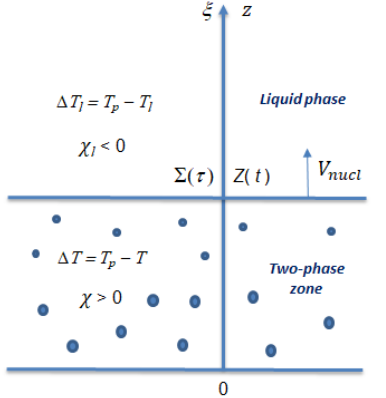
Figure 1. An illustration of the phase transition process where nucleation and growth of crystallites of different sizes (filled circles) are taking place. The crystallization process moving with velocity V nucl is directed along the spatial axis ξ . The two-phase layer–liquid phase boundary Σ ( τ ) moves due to the predominant nucleation of crystals. Symbols z and Z ( t ) designate dimensionless values of ξ and Σ ( τ ) , respectively. The dimensionless melt undercooling in the two-phase layer ( χ = ∆ T / ∆ T liquid phase ( χ l = ∆ T l / ∆ T 0 ) becomes zero at the phase transition boundary ξ = Σ ( τ ) (or z = Z ( t ) ). Here, T p and T 0 are the phase transition and initial temperatures, respectively; T and T l are the current temperatures in the two-phase layer and liquid phase,